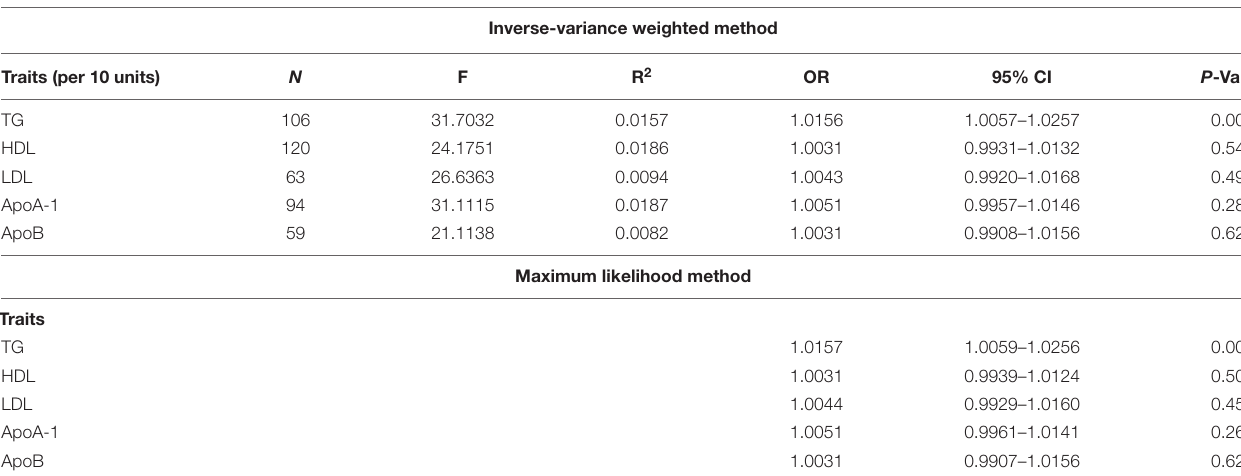
FIGURE 3 | Schematic representation of multivariable Mendelian randomization. TABLE 1 | Mendelian randomization estimates lipid profiles and sleep